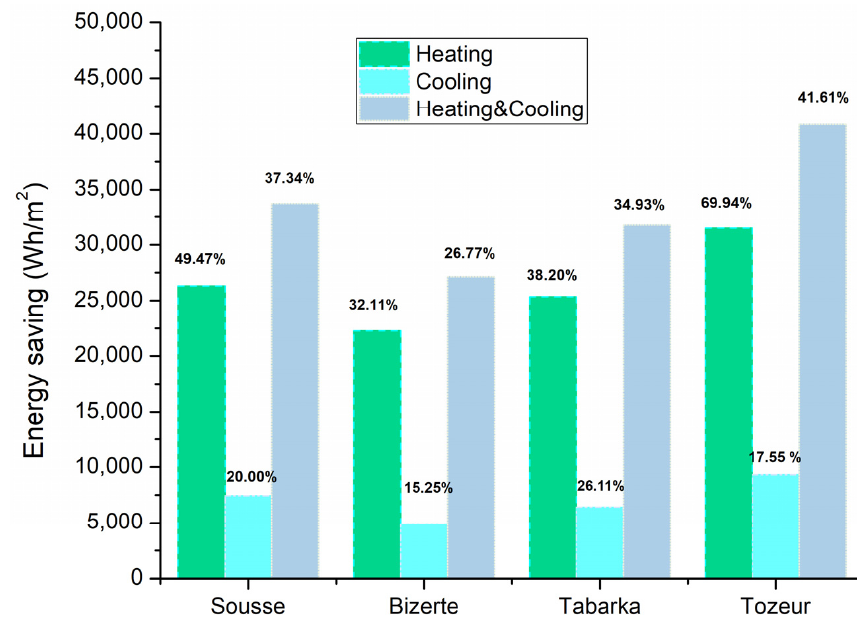
Figure 9. Energy saving in the optimum case.